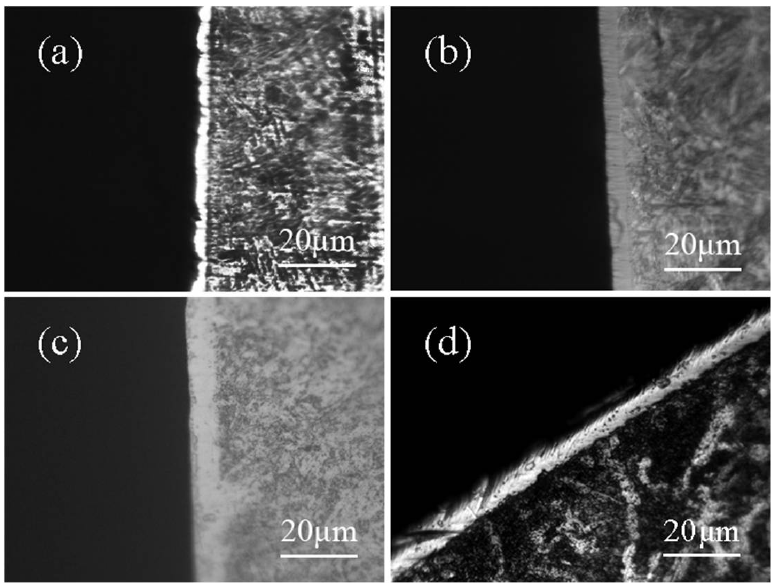
Figure 1. The cross-sectional microstructure of specimens chromized for 5 h at different temperature and chromium electroplated. ( a ) 930 °C; ( b ) 960 °C; ( c ) 980 °C; ( d ) chromium electroplated.